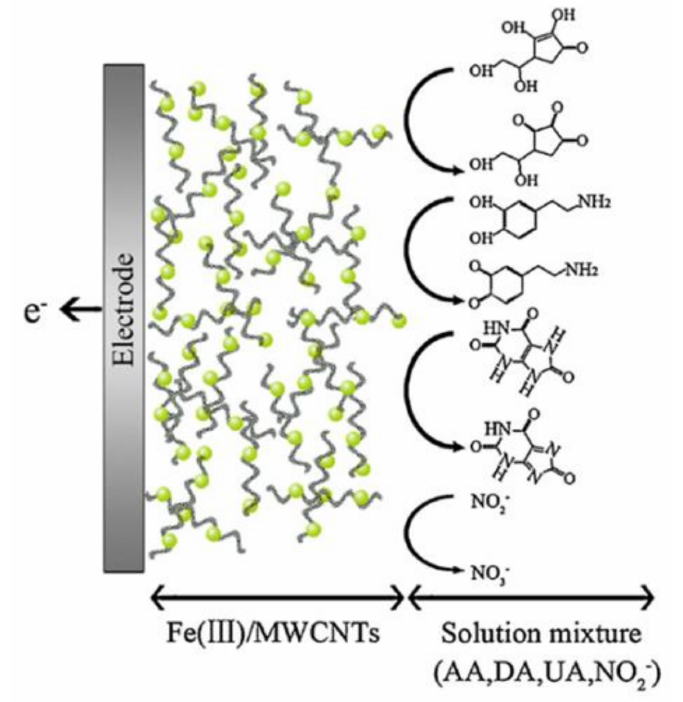
Figure 6. Multiple oxidation process of ascorbic acid (AA), dopamine (DA), uric acid (UA), and nitrite (NO 2 − ). Redrawn with permission of Elsevier from Reference